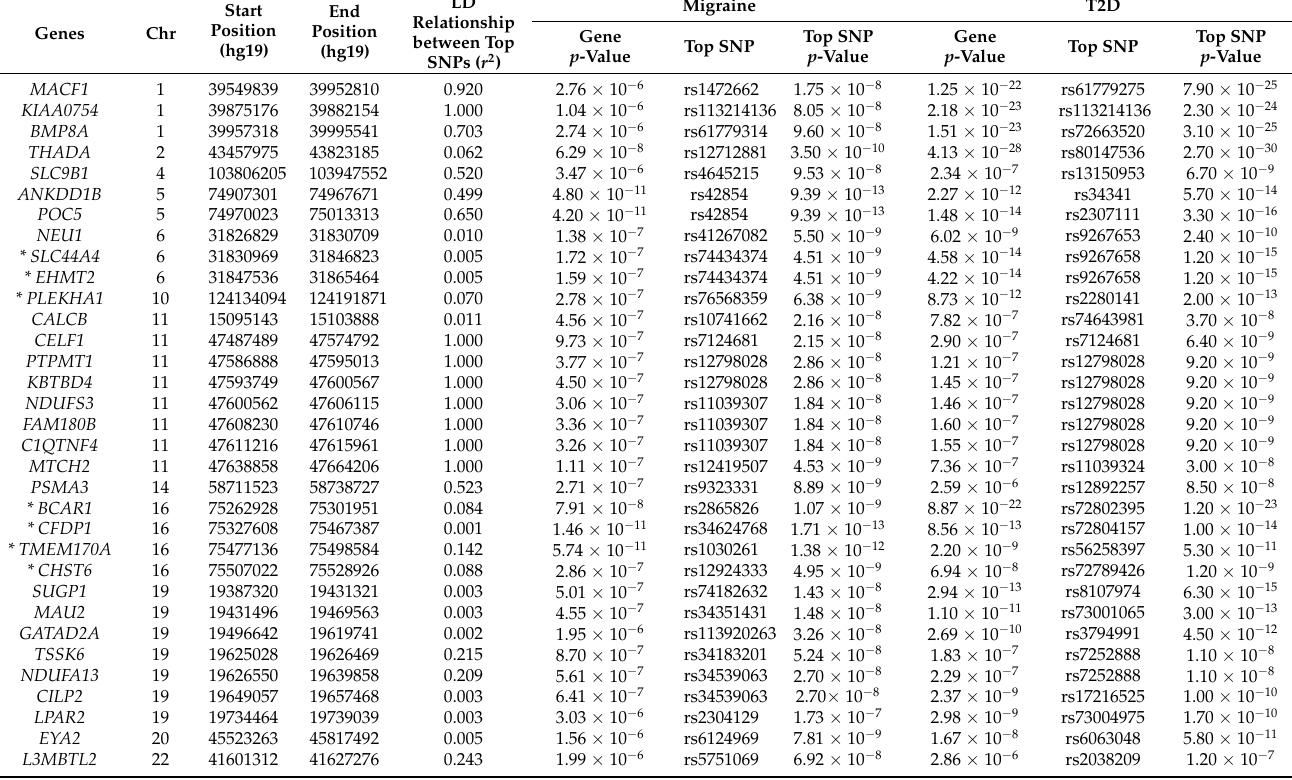
Table 7. Genome-wide significant genes for migraine and T2D.